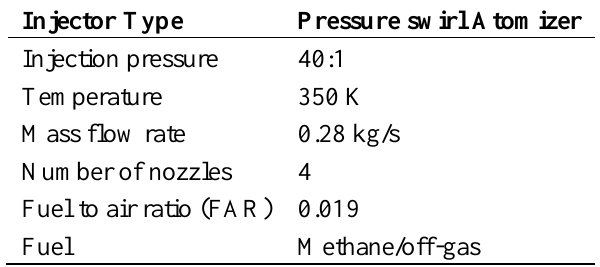
Table 2. Fuel injector: system specifications at nominal